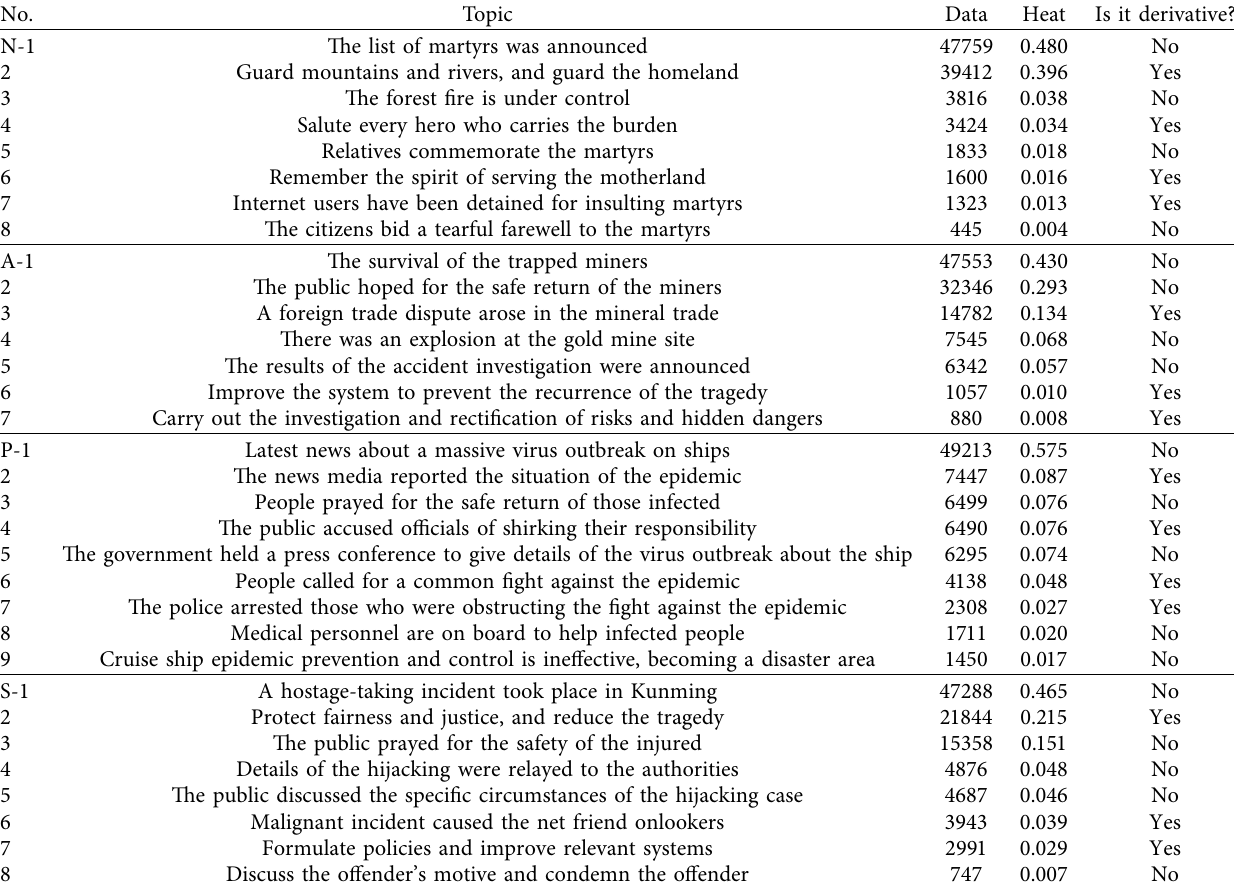
Table 4: Topic clustering and heat comparison of various types of emergencies.